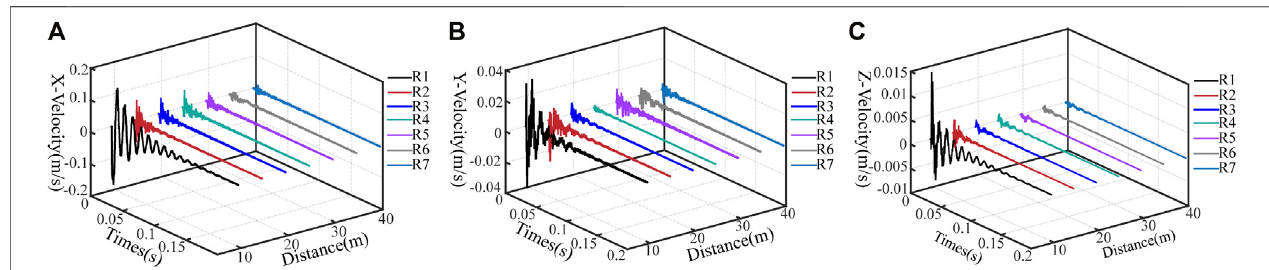
FIGURE 10 | Variation trend of vibration velocity under asymmetric blasting. (A) X-directional velocity; (B) Y-directional velocity; (C) Z-directional velocity.